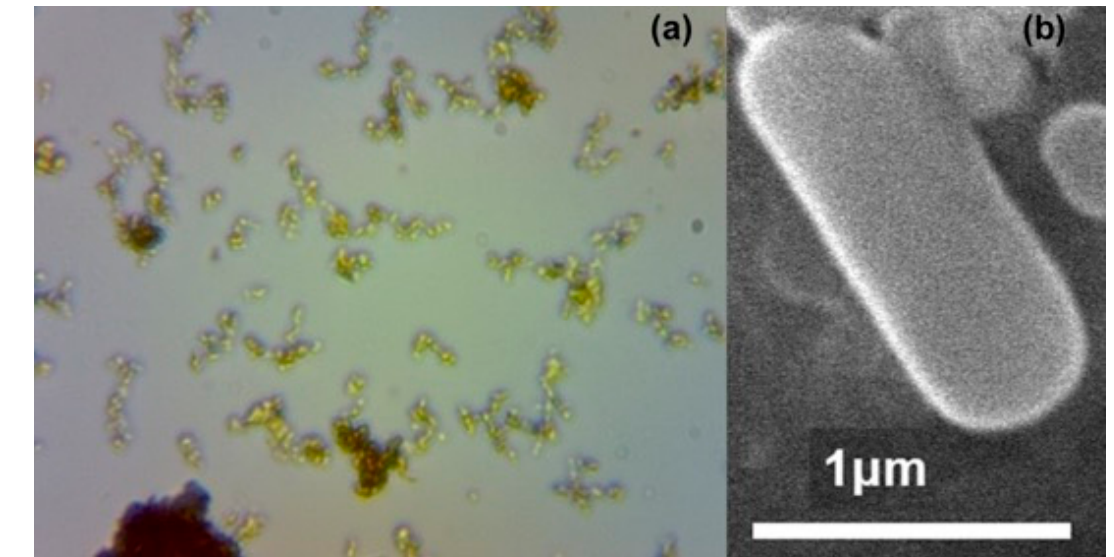
Figure 1. ( a ) Bacterial cells from the T6 remnant solution from a biohydrometallurgical process, observed under an optical microscope (40 × ). ( b ) An image obtained by SEM (20,000 × ) shows a single cell from T6.